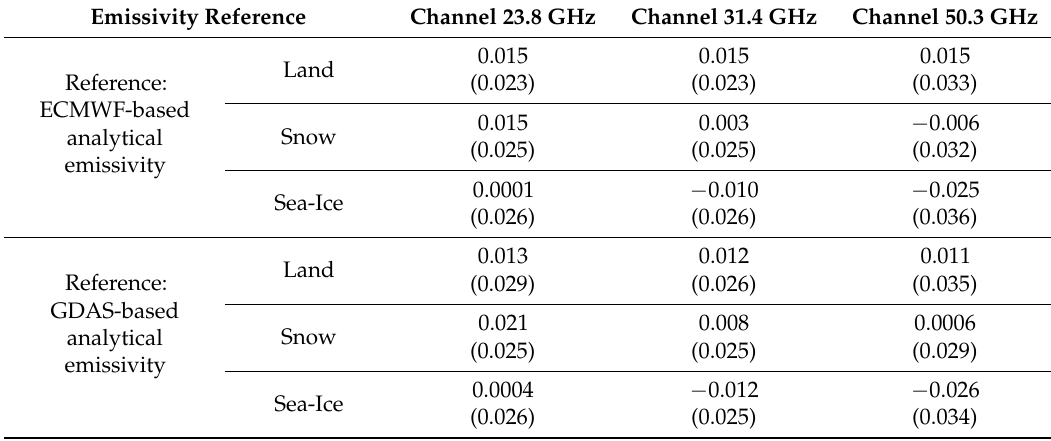
Table 1. Performance of MiRS-based emissivities for three channels from NOAA-18 AMSU, when considering European Centre for Medium-Range Weather Forecasts (ECMWF)-based and GDAS-based analytically computed emissivities as references. Performance is shown in terms of bias (standard deviation) for land, snow and sea-ice surfaces.